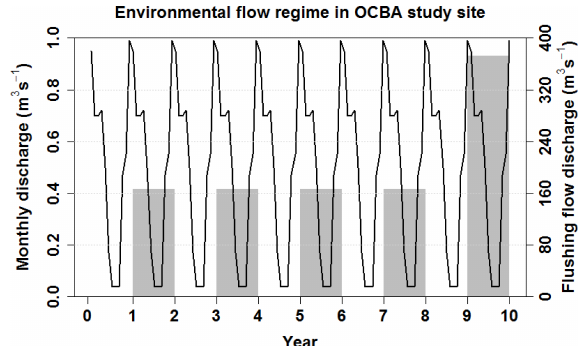
Figure 2. Environmental flow regime addressing fish (black line, left axis) and riparian (grey bars, right axis) requirements consid- ered for the habitat modeling in the OCBA study site. Fish re- quirements are addressed by a constant monthly discharge and ri- parian requirements by a flushing flow in the years in which they are planned (the duration of the flushing flow is similar to a natu- ral flood with an equal recurrence interval). The hydrograph for the Eflow&Flush flow regime is similar in the OCPR study